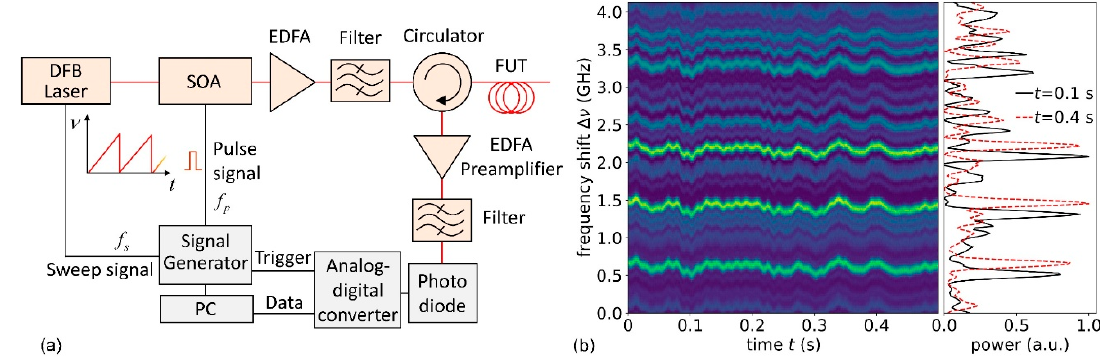
Figure 1. ( a ) Schematic of the WS-COTDR setup (EDFA – Erbium-doped fiber amplifier). ( b ) Measured raw data sweep results (Rayleigh backscattering power) for a single distance sample z = 72.8 m, from measurement shown in Figure 2a. ( f s = 1 kHz, f p = 200 kHz, 1 m spatial